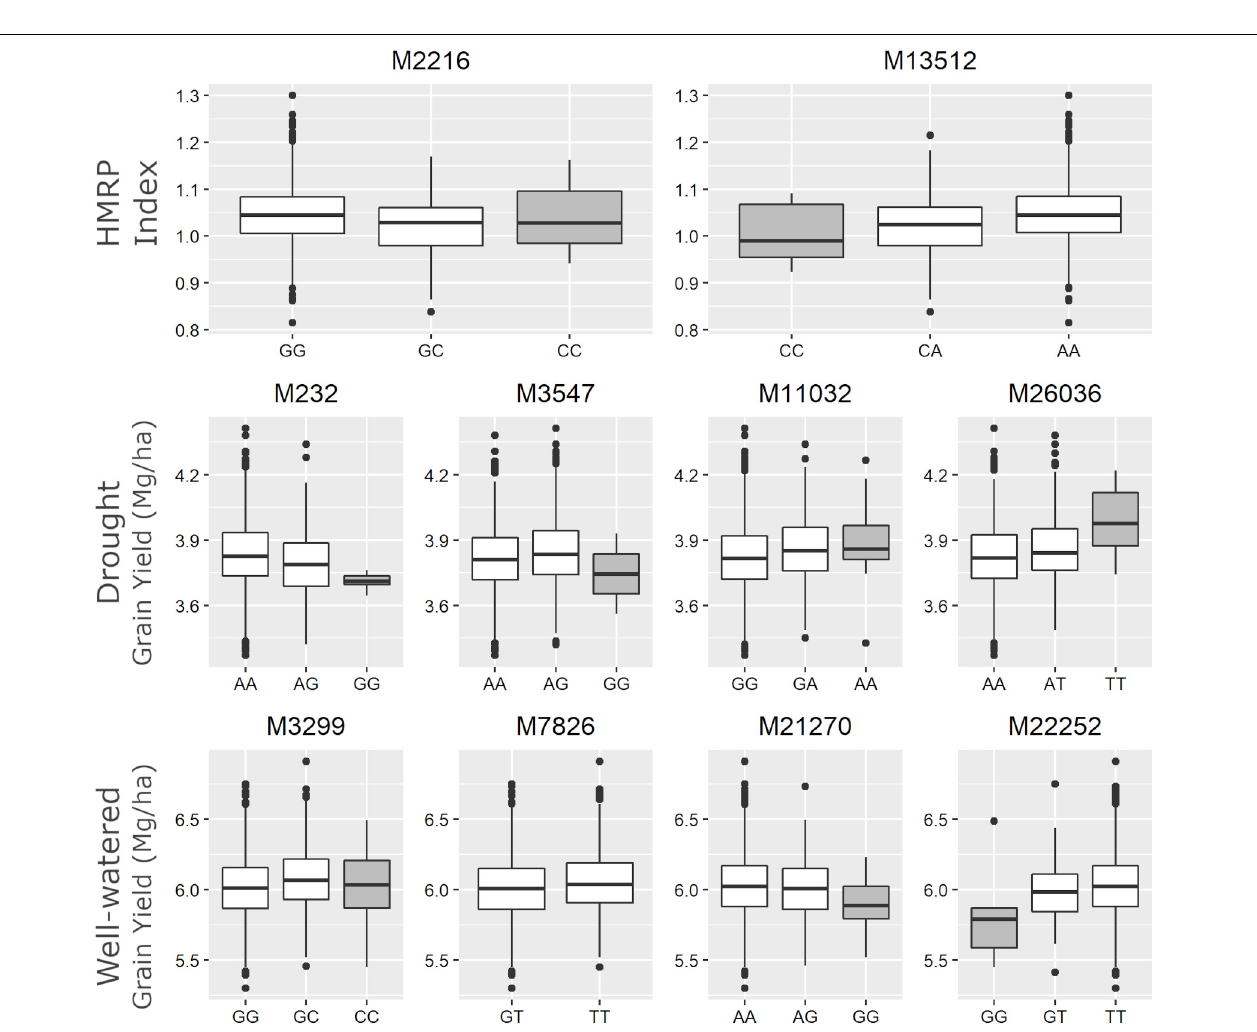
FIGURE 5 | Boxplot of drought tolerance index (first row - HMRP) and grain yield in drought and well-watered conditions (second row – GYDR, third row - GYWW) of each genotype class for the 10 associated SNPs. The gray boxes highlight the homozygote genotype for the landrace origin allele.